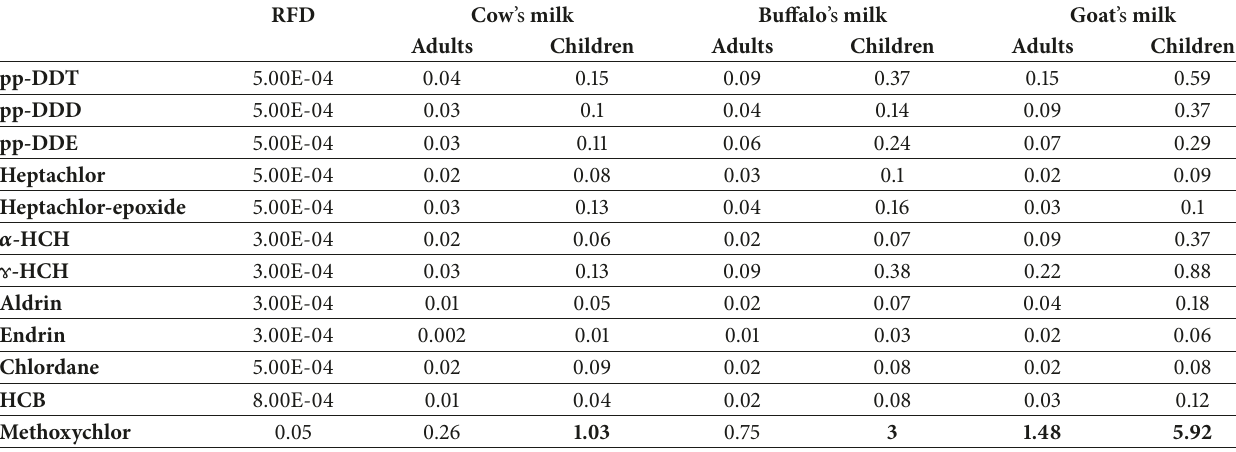
Table 2: Noncancer hazard ratio among Egyptian population due to ingestion of OCPs-contaminated milk from different animal species.